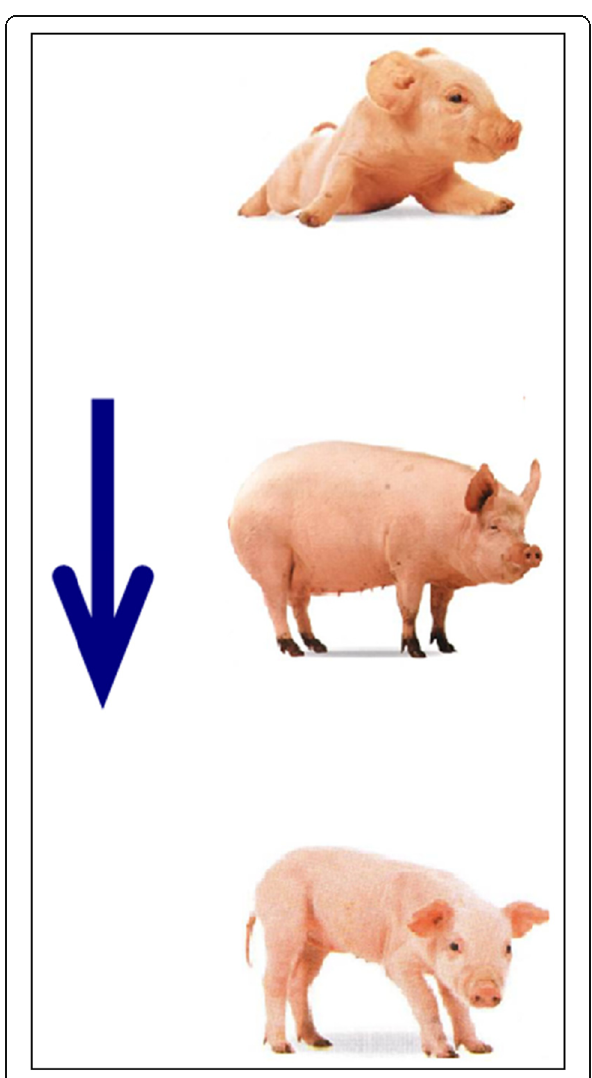
Fig. 4 An example of a vertical space-time compatible target. This is an instance of a false